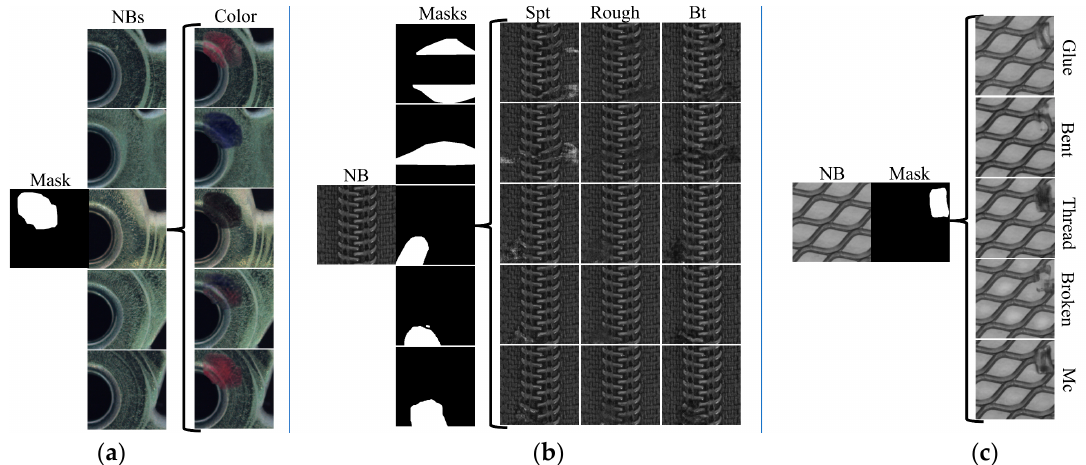
Figure 6. Examples of one-to-many generation. NB and mask denote the normal background and the binary mask input into MDGAN, respectively. (a) Background variation. Color denotes the generated metal nut color defects. (b) Defect shape and texture variation. Spt, Rough , and Bt denote the three types of zipper defects generated from the same background. (c) Defect texture variation.